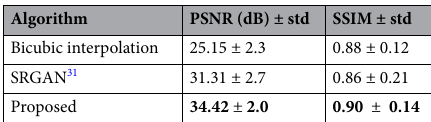
Table 5. Results on skin images dataset. Significant values are in